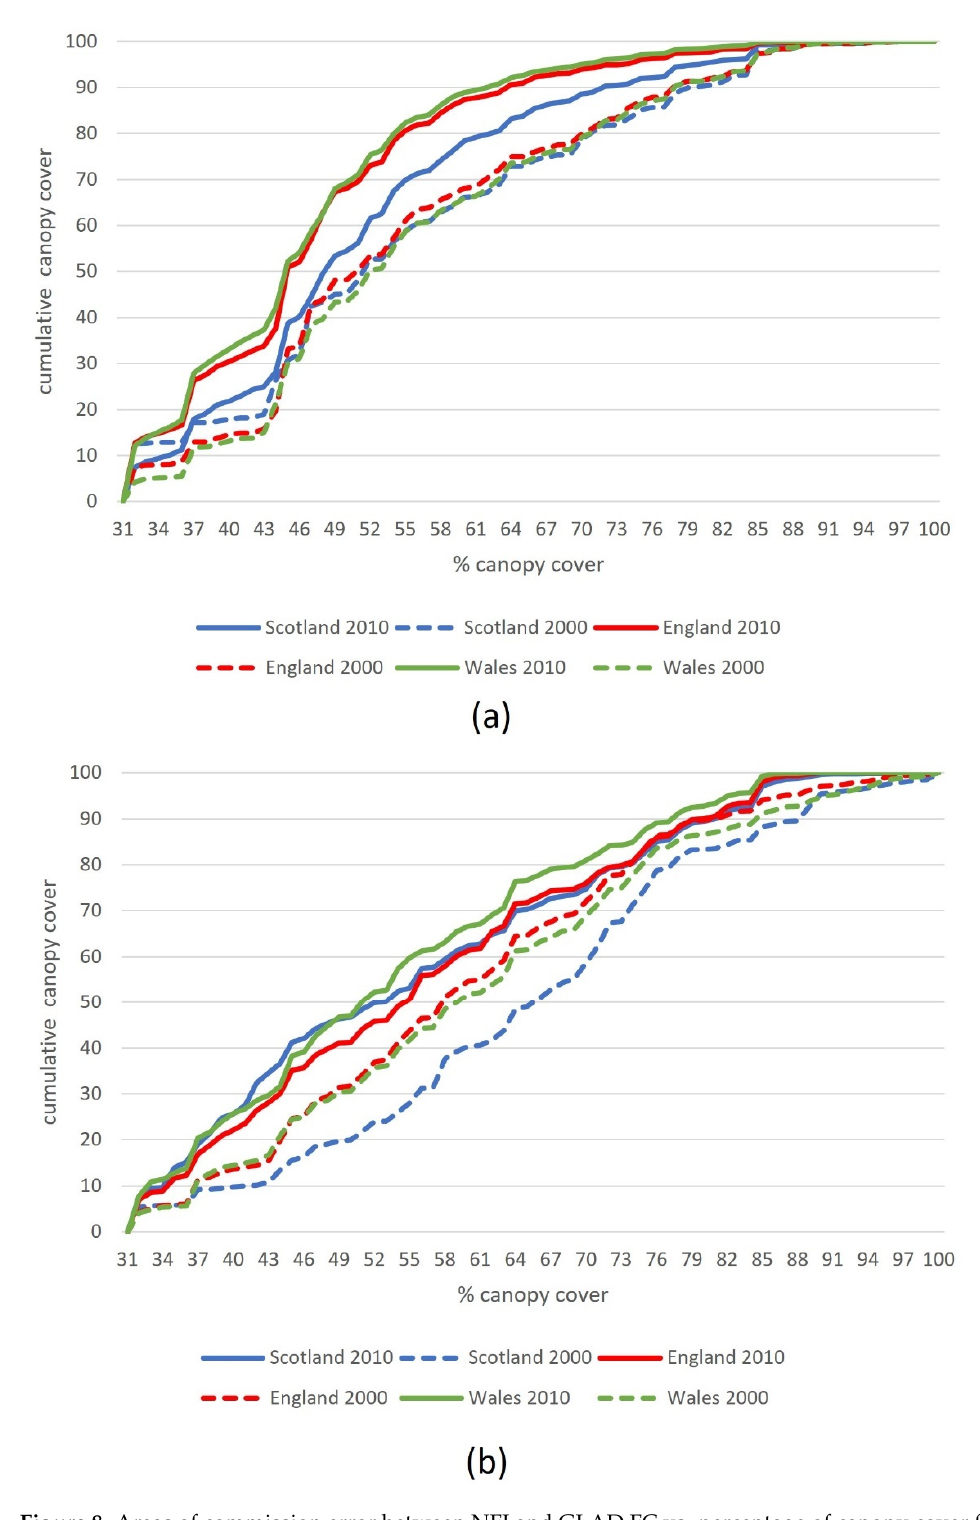
Figure 8. Areas of commission error between NFI and GLAD FC vs. percentage of canopy cover for ( a ) Heather habitat and ( b ) Improved grassland habitat. ( a ) Heather habitat and ( b ) Improved grassland